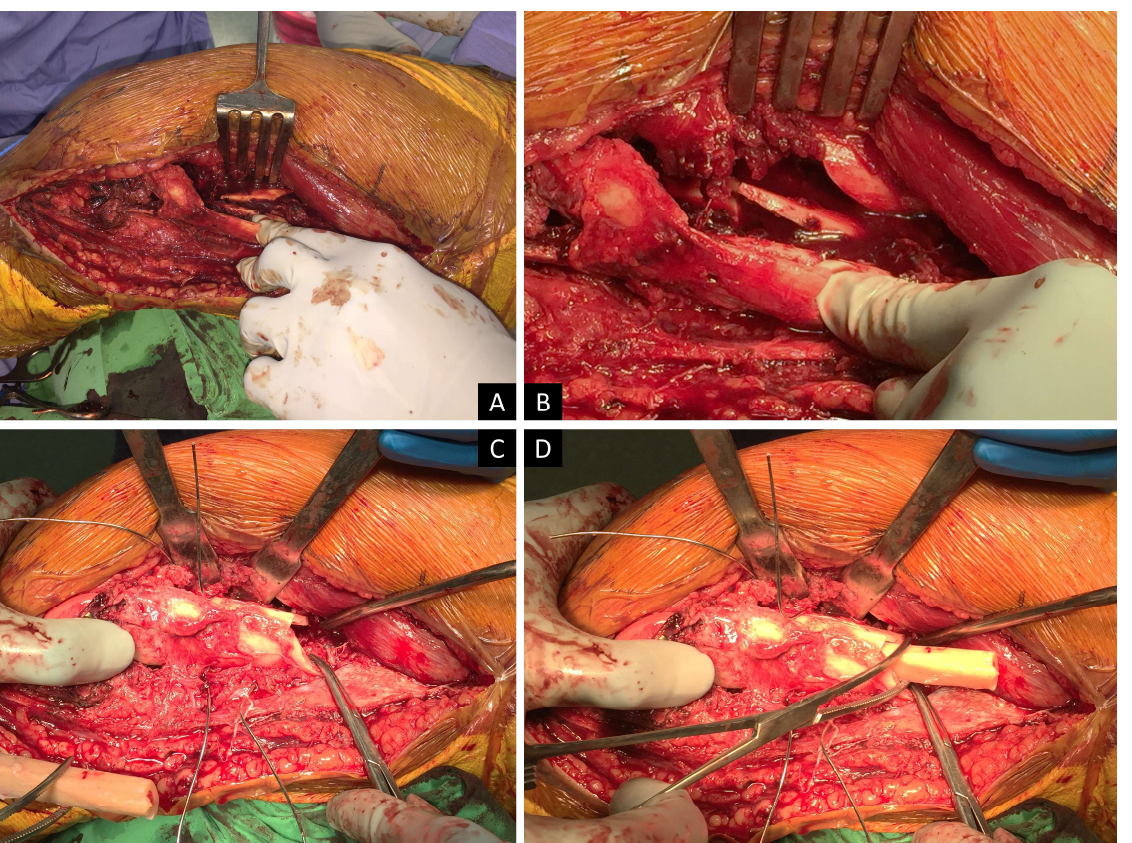
Figure 1. This is a 49-year-old female patient without any systemic disease admitted to our emergency department due to a traffic accident. Distal femoral fracture with AO33-C2 was diagnosed (Figure 3). Severe comminution of metaphysis with large bone defect was noted ( A , B ). We repositioned all the bone fragments ( C ) and an allogenic fibular strut was chosen for restoration of the fractured bone. Wire was applied as an outer restriction for fragment reposition ( D ). Allogenic bone strut supplied an inner supportive structure and wire was tied. Last, a precontoured locking plate was applied and proximal screws were inserted with minimal invasive